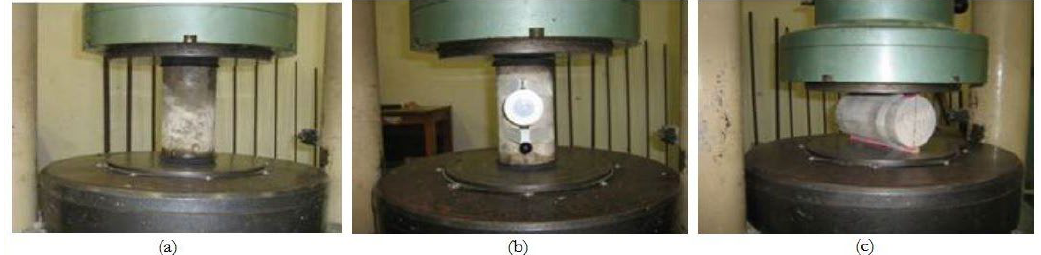
Figure 3. Concrete strength characterization test: (a) compression; (b) elastic modulus; (c) tension by diametral compression.